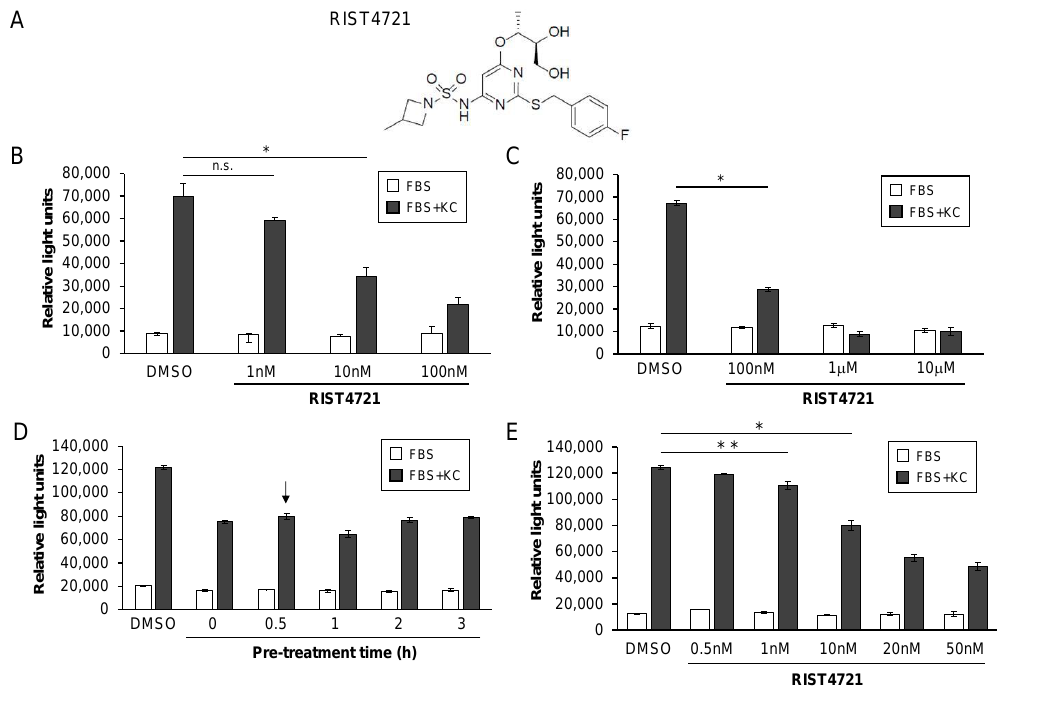
Figure 3. Inhibition of chemotaxis by RIST4721 at varying concentrations. ( A ) Depicted is the chemical structure of RIST4721, which is dissolved in DMSO and added to the cells both prior to chemotaxis tests and within the bottom chamber of the chemotaxis assay transwell plates. ( B , C ) Graphed are chemotaxis responses with neutrophils treated with low concentrations of RIST4721 (1 nM–100 nM) vs. high concentrations of drug (100 nM–10 µ M). ( D ) Shown are graphed chemotaxis responses of neutrophils with different pretreatments with RIST4721, indicating a 30 min pre-incubation (arrow) is sufficient to achieve consistent chemotaxis inhibition. ( E ) Graphed are chemotaxis responses of neutrophils treated with low-range concentrations of RIST4721 used to guide further tests for MIC and IC 50 calculations. The data shown indicate that the MIC needed to inhibit neutrophil chemotaxis oscillated between 1 nM and 5 nM. All data shown are averages ± SD from triplicate tests per assay and represent at least three independent replicates. * p < 0.001, ** p < 0.05, n.s., not